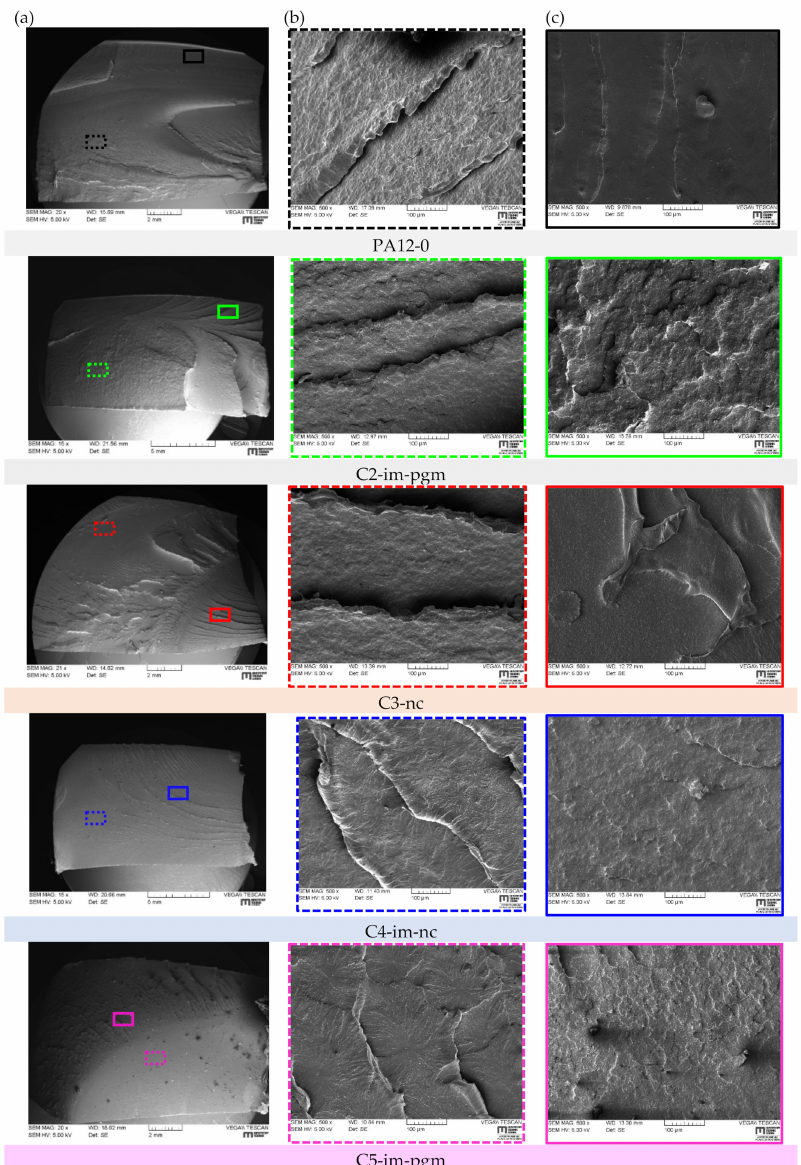
Table 3. Fracture surface analysis of S4 tested PA12 pipe fragments via SEM: macroscopic